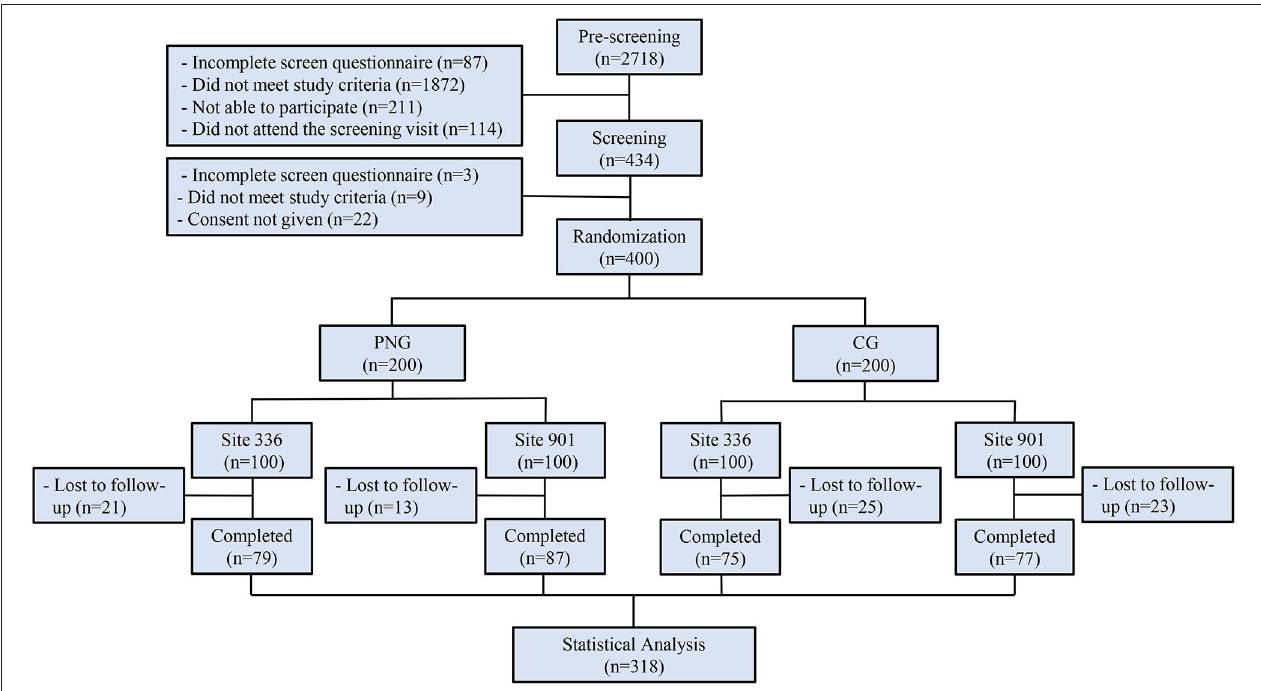
FIGURE 1 | Flowchart of the clinical